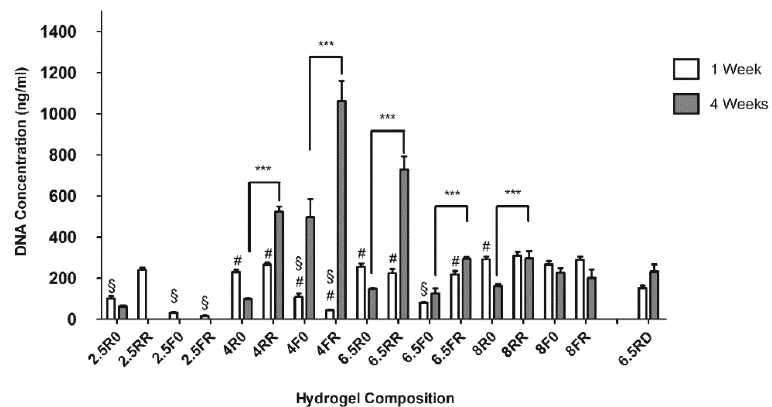
Figure 2. DNA content of cell-laden PEG hydrogels cultured in GM in vitro over time varying in the percentage of macromer, the cross-linker type, and the incorporation or lack of the cell binding motif, RGD, or scrambled peptide, RDG. Results are presented as mean ± SD ( n = 3; # p < 0.001 when comparing the hydrogel composition at 1 week to its 4 week counterpart; § p < 0.01 compared to 1 week DNA content of unmarked hydrogels; *** p <0.001 when comparing otherwise similar hydrogels with and without RGD at 4 weeks).